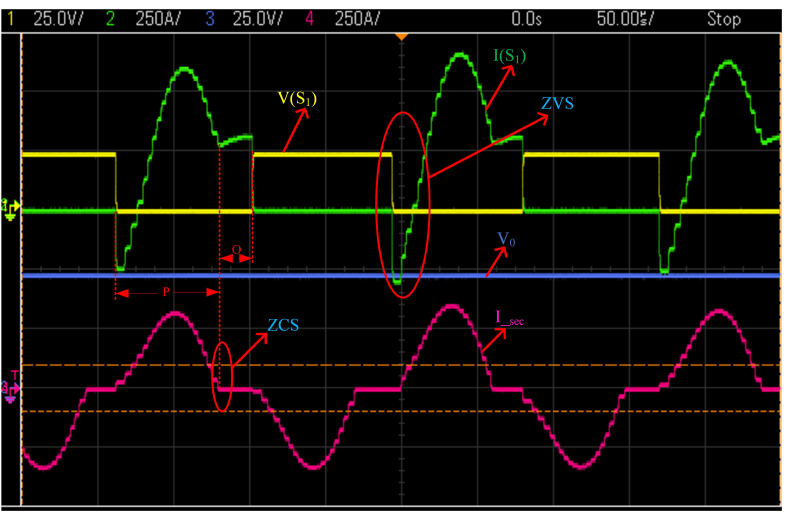
Figure 10. Experimental waveforms of V S rated